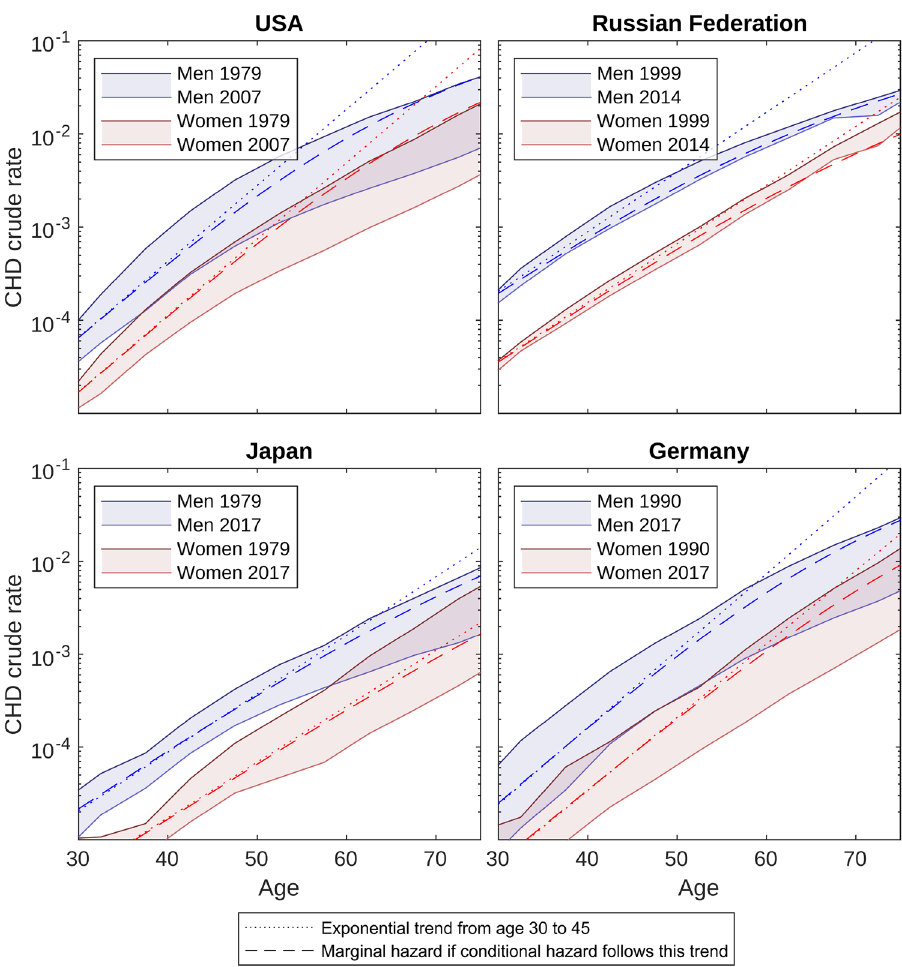
Figure 2. Coronary heart disease (CHD) crude mortality rates according to the WHO Mortality Data Base. To guide the eyes, the area between mortality rates of different calendar years has been shaded. Dashed lines illustrate marginal hazards resulting from unobserved heterogeneity with shape parameter σ = 2 assuming exponentially increasing conditional hazards as delineated with dotted